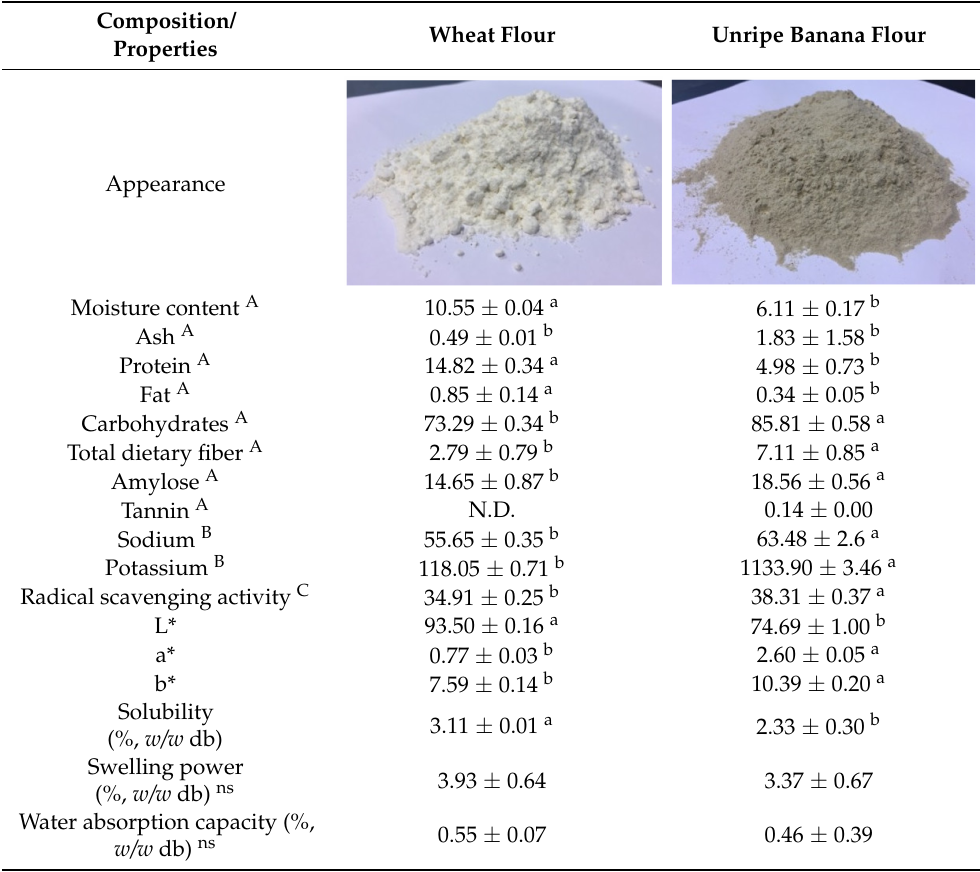
Table 1. Chemical composition, physico-chemical properties, and functional properties of wheat flour and unripe banana